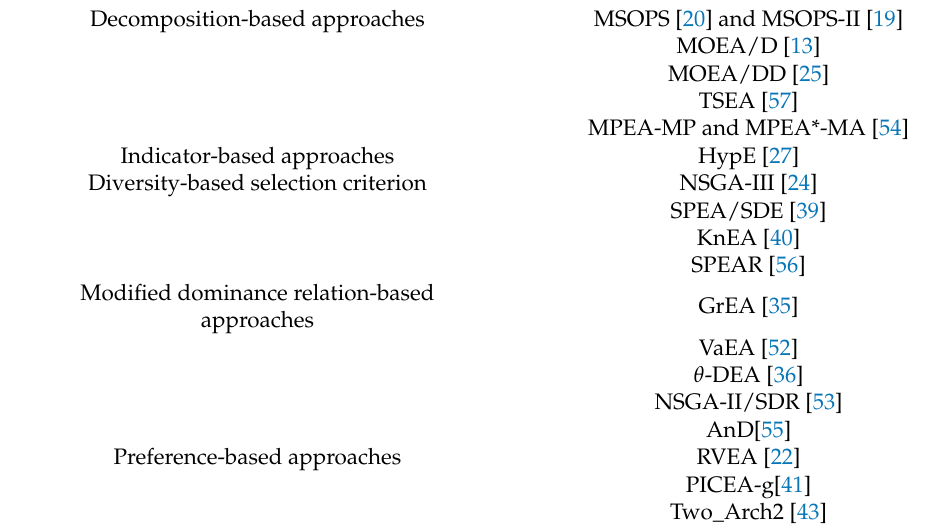
Table 2. Classification of the MOEAs for